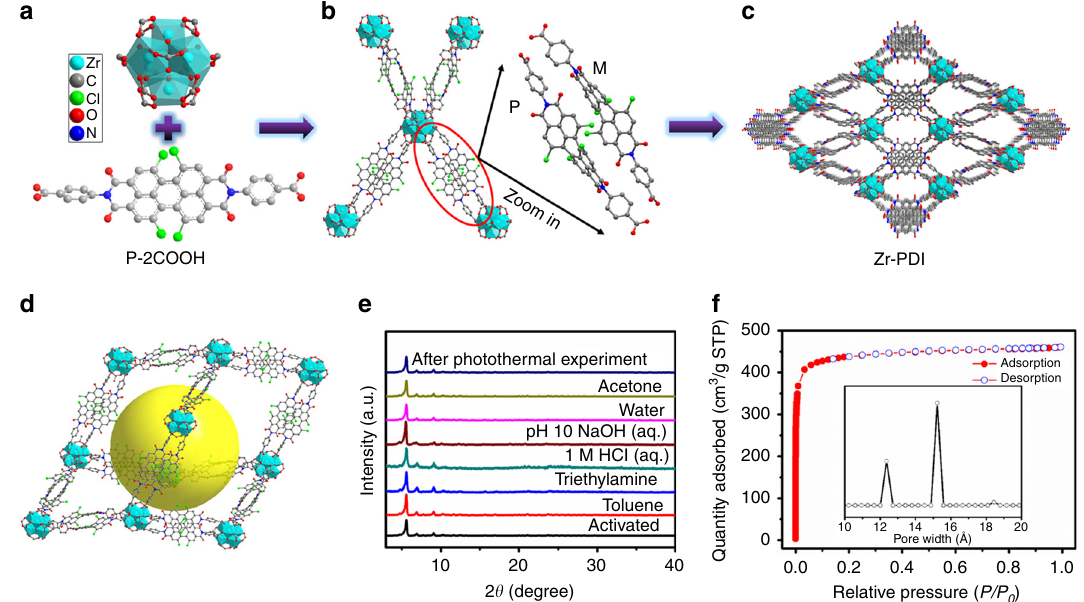
Fig. 1 Synthesis of 3D porous Zr-PDI. a Structures of Zr-cluster and P-2COOH. b Connection mode of Zr-cluster (the Zr-cluster is fully coordinated by 12 carboxylate units) and molecular arrangement of chiral P-2COOH. c a-Axis crystal structure of Zr-PDI. d Single distorted adamantanoid cage (the distorted cage is similar to adamantane) in Zr-PDI. Hydrogen atoms have been omitted for clarity. e Results of stability tests of Zr-PDI incubated under various conditions for 24 h. Zr-PDI powder is washed with acetone and dried under vacuum at 120 °C prior to measurement. f N 2 sorption isotherm at 77 K and corresponding pore size